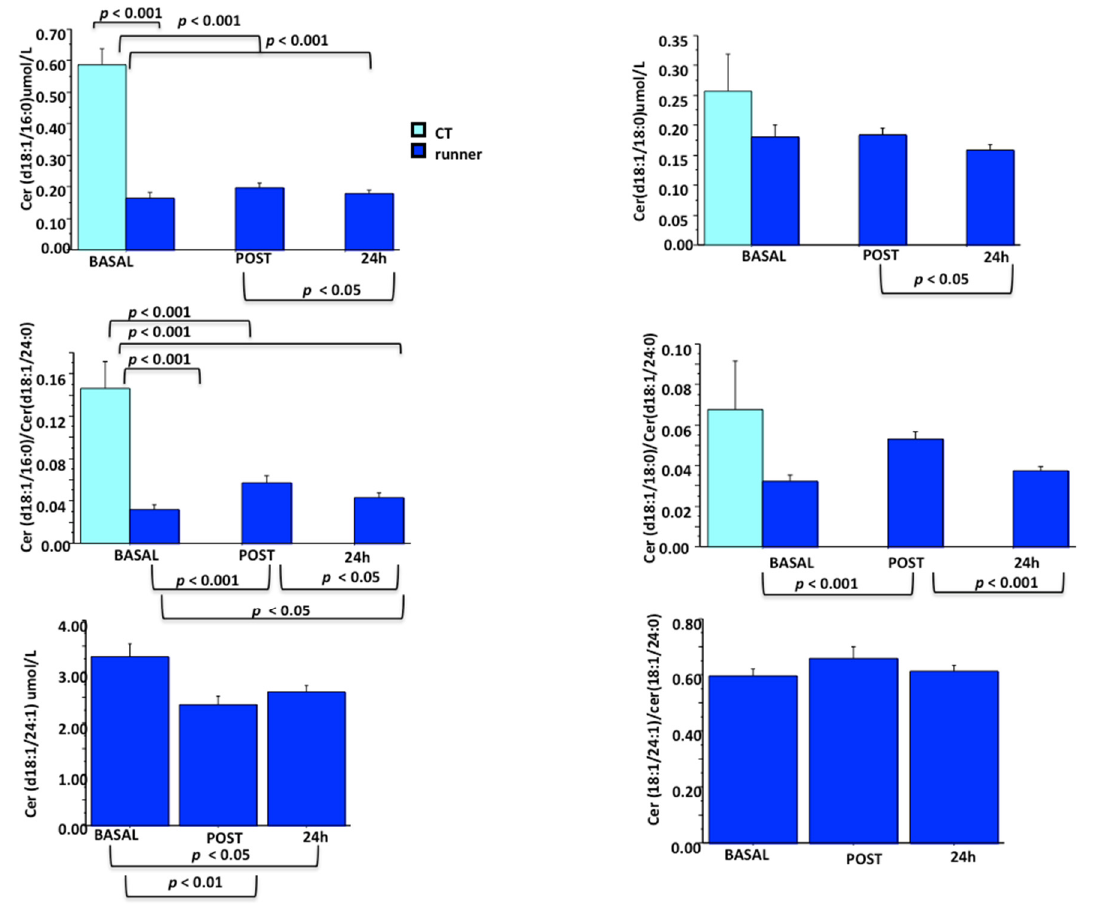
Figure 3. CERT1 components in sedentary subjects ( n = 17) and in trained runners ( n = 13) before a half-marathon and during recovery. ANOVA analysis and Scheffe’s post hoc